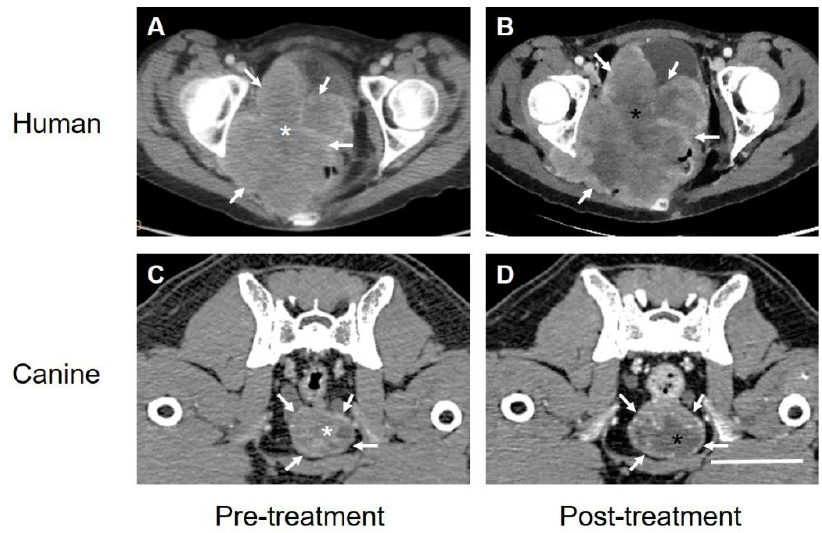
Figure 3. The computer tomographic images of the Stage IIB SCCA of the cervix(A,B) obtained from the patient in Figure 2 and a carcinoma of the prostate obtained from a companion canine ( C , D ) before ( A , C ) and 3–5 days after ( B , D ) treatment with TOL. The images before and after treatment were chosen to depict the respective tumors at levels as closely similar as possible. White arrows indicate points on the surface of the respective mass. Note that the relative size of both types of carcinoma, in the human and the dog post-treatment appears similar if not slightly larger than prior to treatment. By contrast, areas of hypodensity observed within the tumor mass appear larger and much more prominent after treatment (black asterisks) compared to pretreatment (white asterisks) with the region of interest (ROI) measurements of Hounsfield unit densities decreasing from 70 to 56 HU by 3 days post-treatment. Additional region of ROI reference measurements were made for each scan over pelvic musculature revealing values of 127 HU ( A , C ) and 120 HU ( B , D ), respectively. Calibration bar in D = 5 cm.